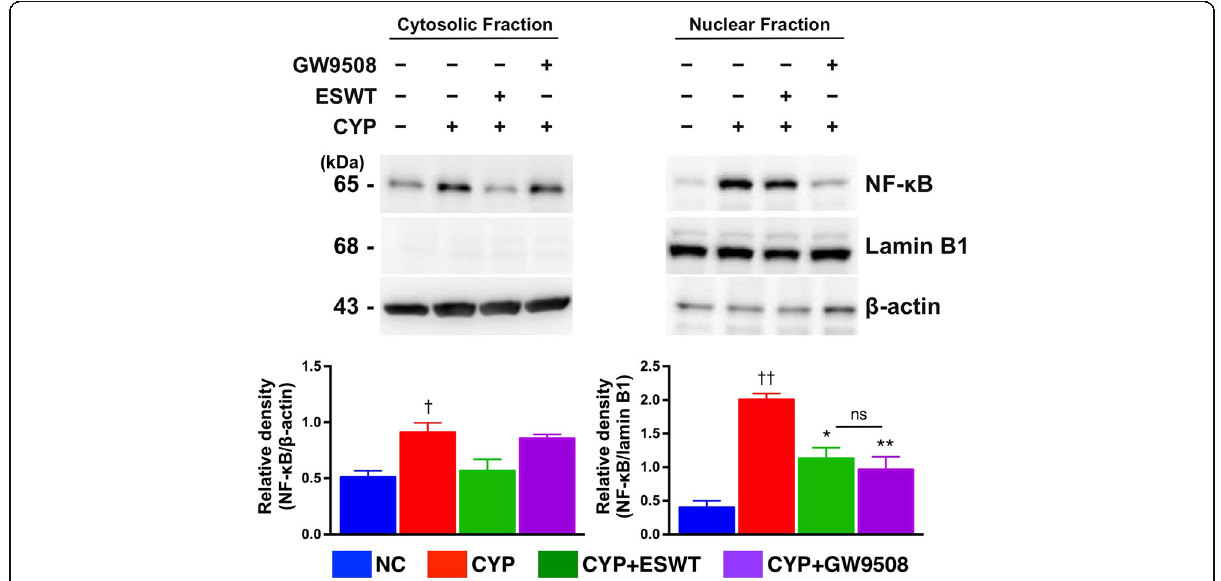
Fig. 4 Effects of extracorporeal shock wave treatment (ESWT) and GPR120 agonist on nuclear factor- κ B (NF- κ B) translocation in cyclophosphamide (CYP)-stimulated RT4 cells. β -actin and lamin B1 used as internal controls for cytosolic and nuclear fractions, respectively. Values expressed as the mean ± SD of three independent experiments. * p < 0.05, ** p < 0.01 vs. CYP; † p < 0.05, †† p < 0.01 vs. control; ns, non- significance. Significance of differences determined by one-way ANOVA followed by Bonferroni ’ s post-hoc comparisons